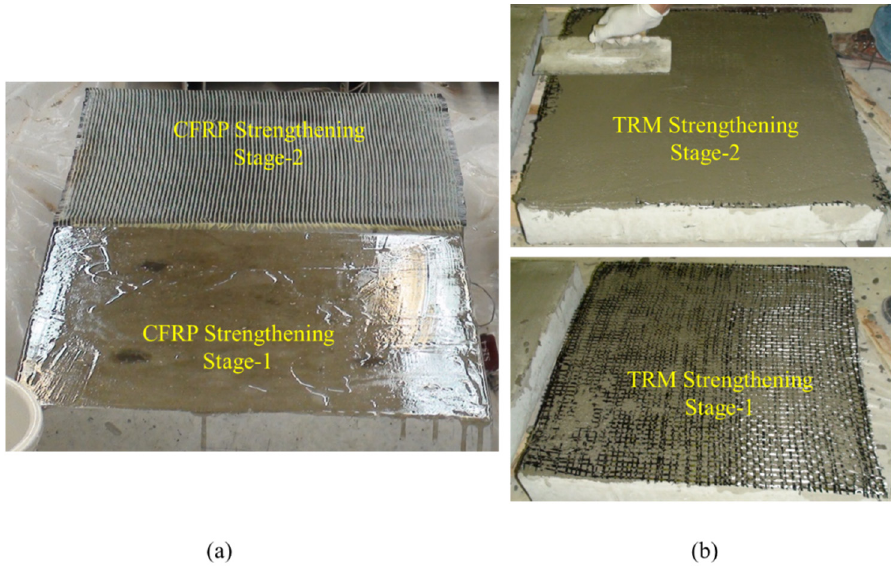
Figure 2. RC slabs strengthened with externally bonded: ( a ) CFRP sheet; and ( b ) TRM. There were two batches of slab specimens for the two concrete mixes, M1 and M2.